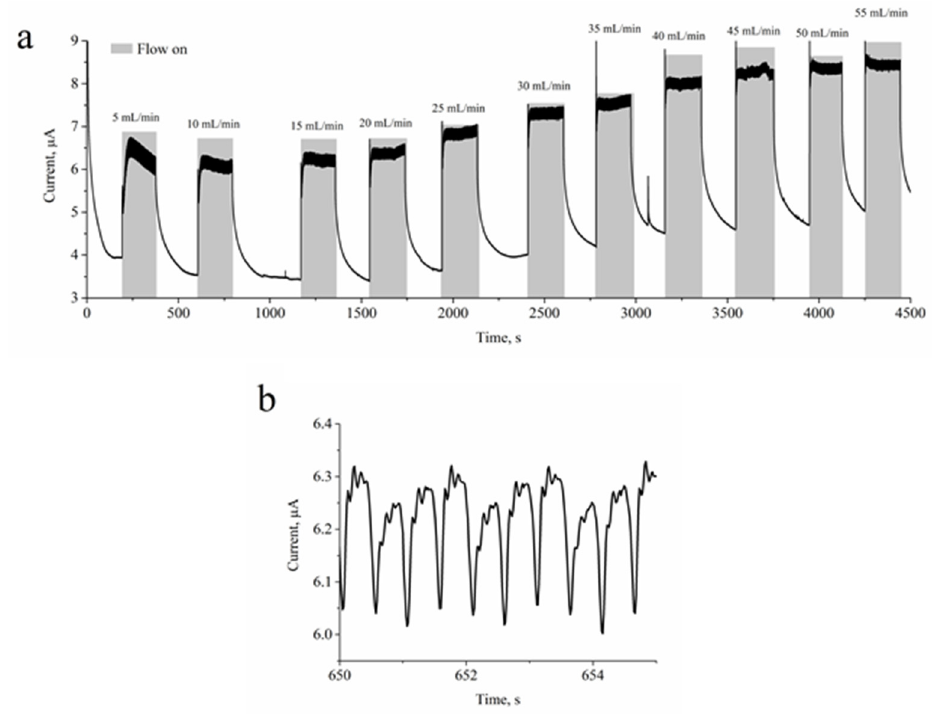
Figure 5. ( a ) Three-electrode configuration flow cell experiment where RE electrode was tested at various flow rate conditions. Measurements performed using 5 mM potassium ferrocyanide and 0.1 M sodium phosphate buffer, pH 7.0, at 0.4 V set to working platinum electrode. ( b ) High resolution graph of the same experiment at flow rate of 10 mL/min from 650 to 655 s.